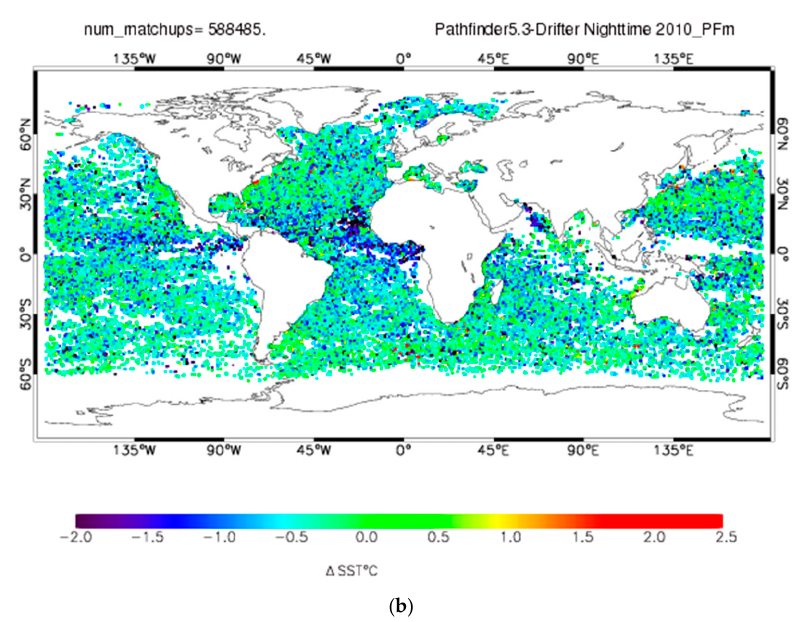
Figure 1. ( a ) ARC-Drifters for a full year (2010); ( b ) PF53-Drifter for the same year.